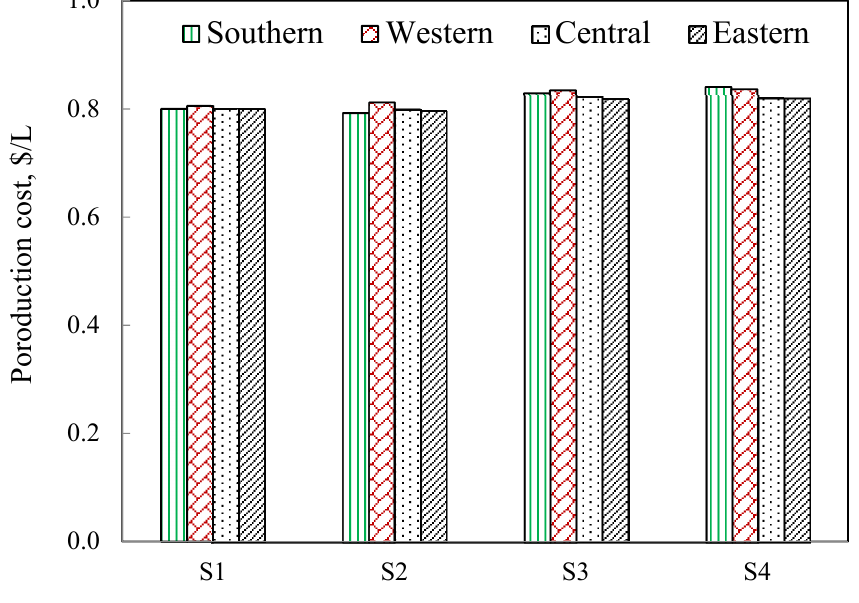
Figure 7. Net production cost at different locations in